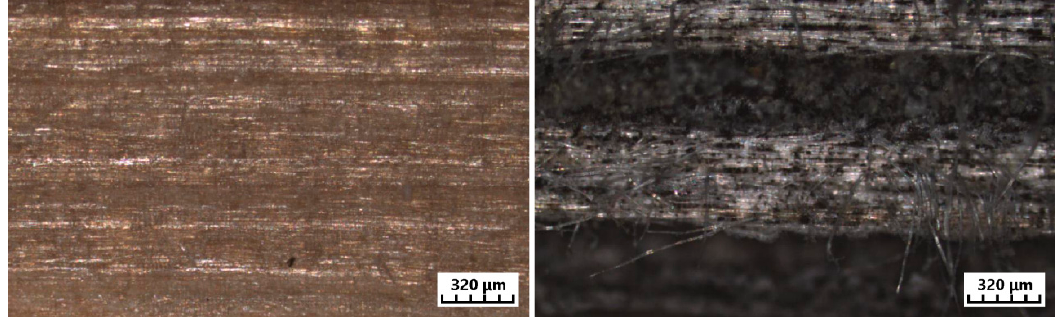
Figure 7. Confocal microscopy of samples during exposure to natural weathering (each scan corresponds to an area of 2.5 × 2.5 mm).